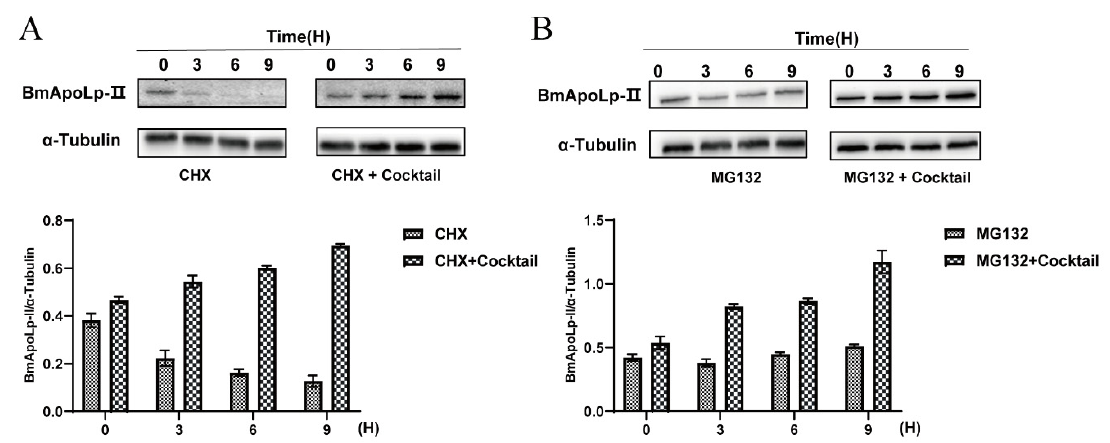
Figure 5. Acetylation could improve the stability of protein in cells. ( A ) The influence of up-regulation of acetylation by cocktail on BmApoLp-II protein degradation where CHX blocking intracellular protein synthesis pathway. ( B ) The influence of up-regulation of acetylation by cocktail on BmApoLp-II protein accumulation where MG132 is blocking the intracellular protein degradation pathway. CHX, cycloheximide; TSA, trichostatin A.